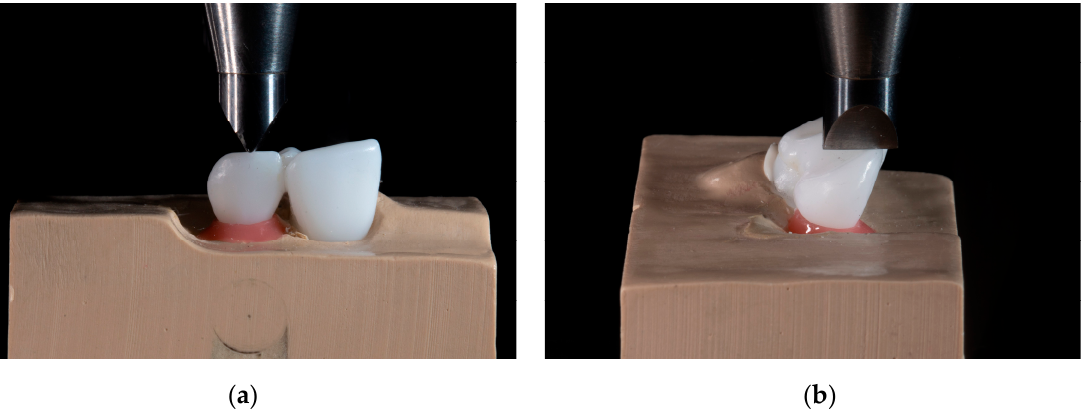
Figure 3. Quasi-static loading. The load was transferred through a blade positioned perpendicular to the incisal edge of the pontic. ( a ) Frontal view; ( b ) lateral view.